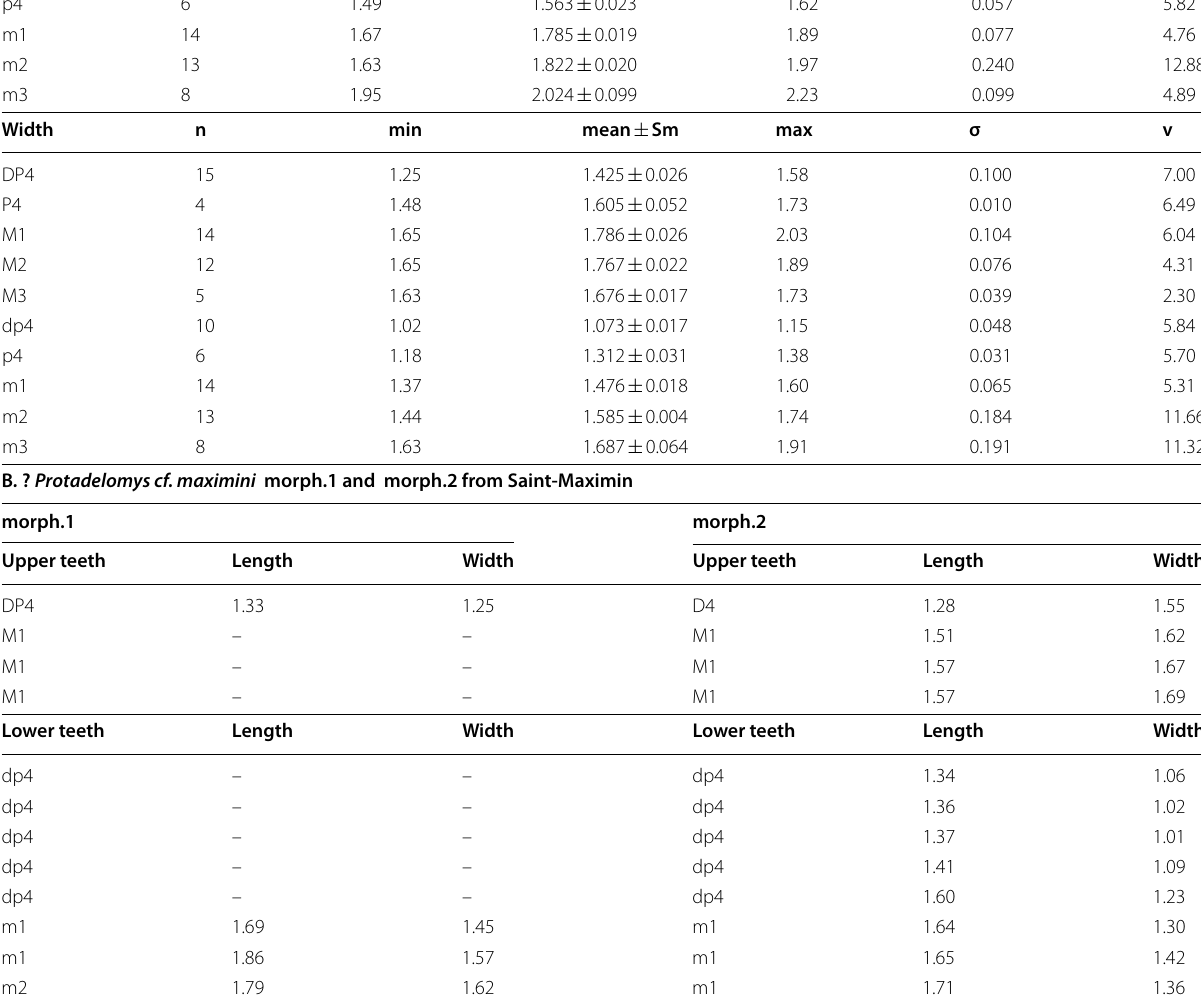
Sm σ/ √ n; v 100 σ/average L or W): A. of the different ± = =